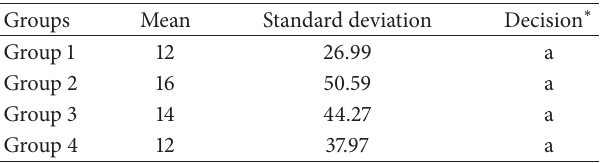
Table 3: Mean values for voids at the margins ( 𝜇 m).